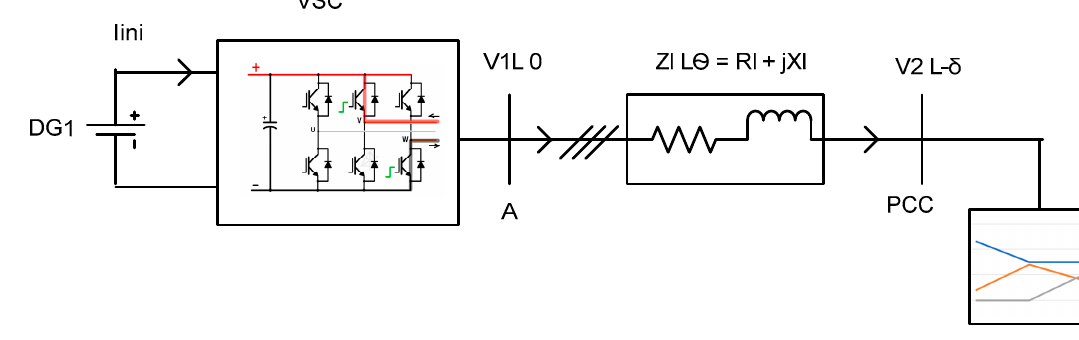
Figure 7. GDC unit diagram.